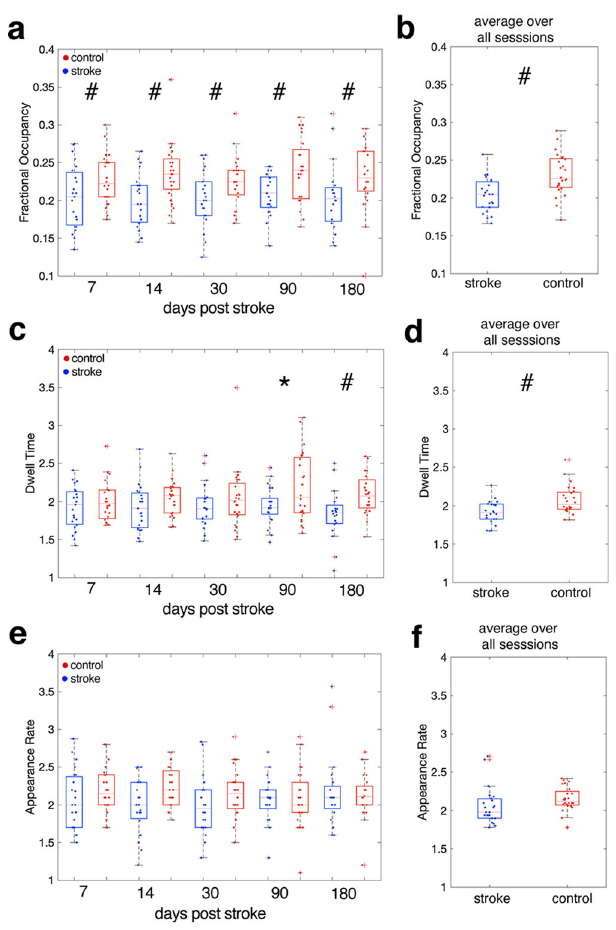
Fig. 3 Group differences in brain state dynamics for FPN + . a , c , e Stroke- control differences in session-speci fi c fractional occupancy (FO), dwell time (DT), and appearance rate (AR) in FPN + over the post-stroke recovery period. c , d , f Stroke-control differences in average FO, DT, and AR (averaged over each subject's 2 – 5 longitudinal sessions). Hashtags ( # ) represent p values < 0.05 after multiple comparisons correction within each parameter (i.e., FO, DT, AR), single asterisks (*) represent signi fi cant uncorrected p values < 0.05. Dwell time shown in units of TRs. n = 24 biologically independent control subjects at each time point; n = 23, 23, 22, 21, 20 biologically independent stroke subjects for time point 1, 2, 3, 4, and 5, respectively. On each box, the central mark indicates the median, and the bottom and top edges of the box indicate the 25th and 75th percentiles,